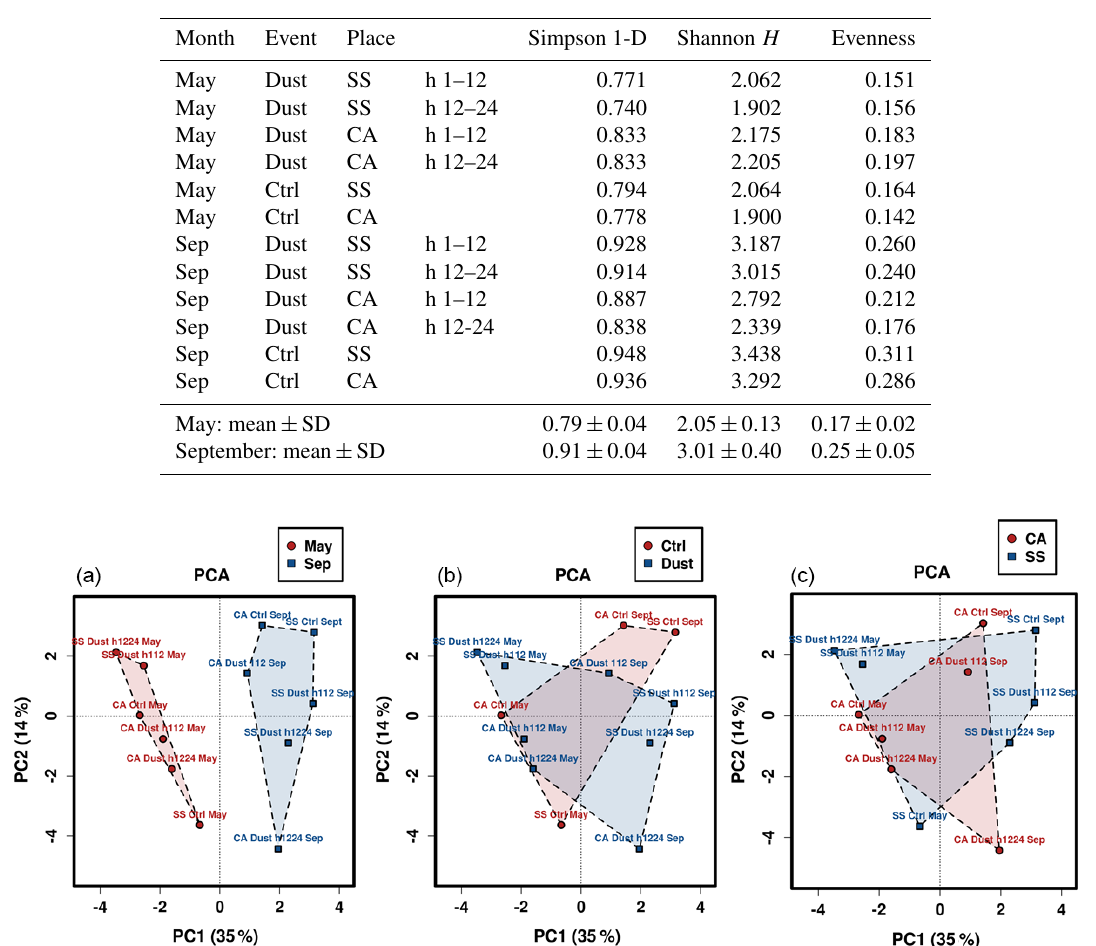
Table 4. Ecological diversity and evenness indexes resulting from the sequence checklist analysis in the different samplings.